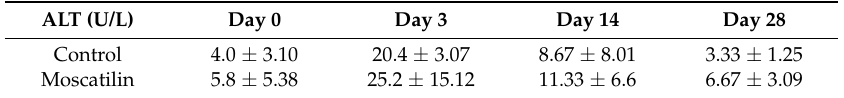
Figure 2. There were no significant differences in body weight growth kinetics between the control and moscatilin-treated groups ( a ). No marked effect was observed in white blood cell counts between the groups ( b ). Table 1. Effects of treatment with control or moscatilin on alanine aminotransferase (ALT) and creatinine levels. Data are presented as mean ± SEM.